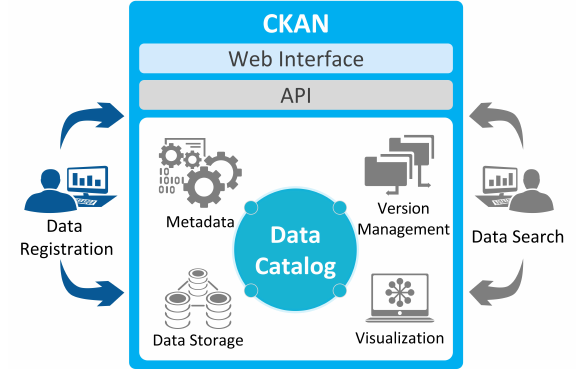
Figure 1. Basic operations of